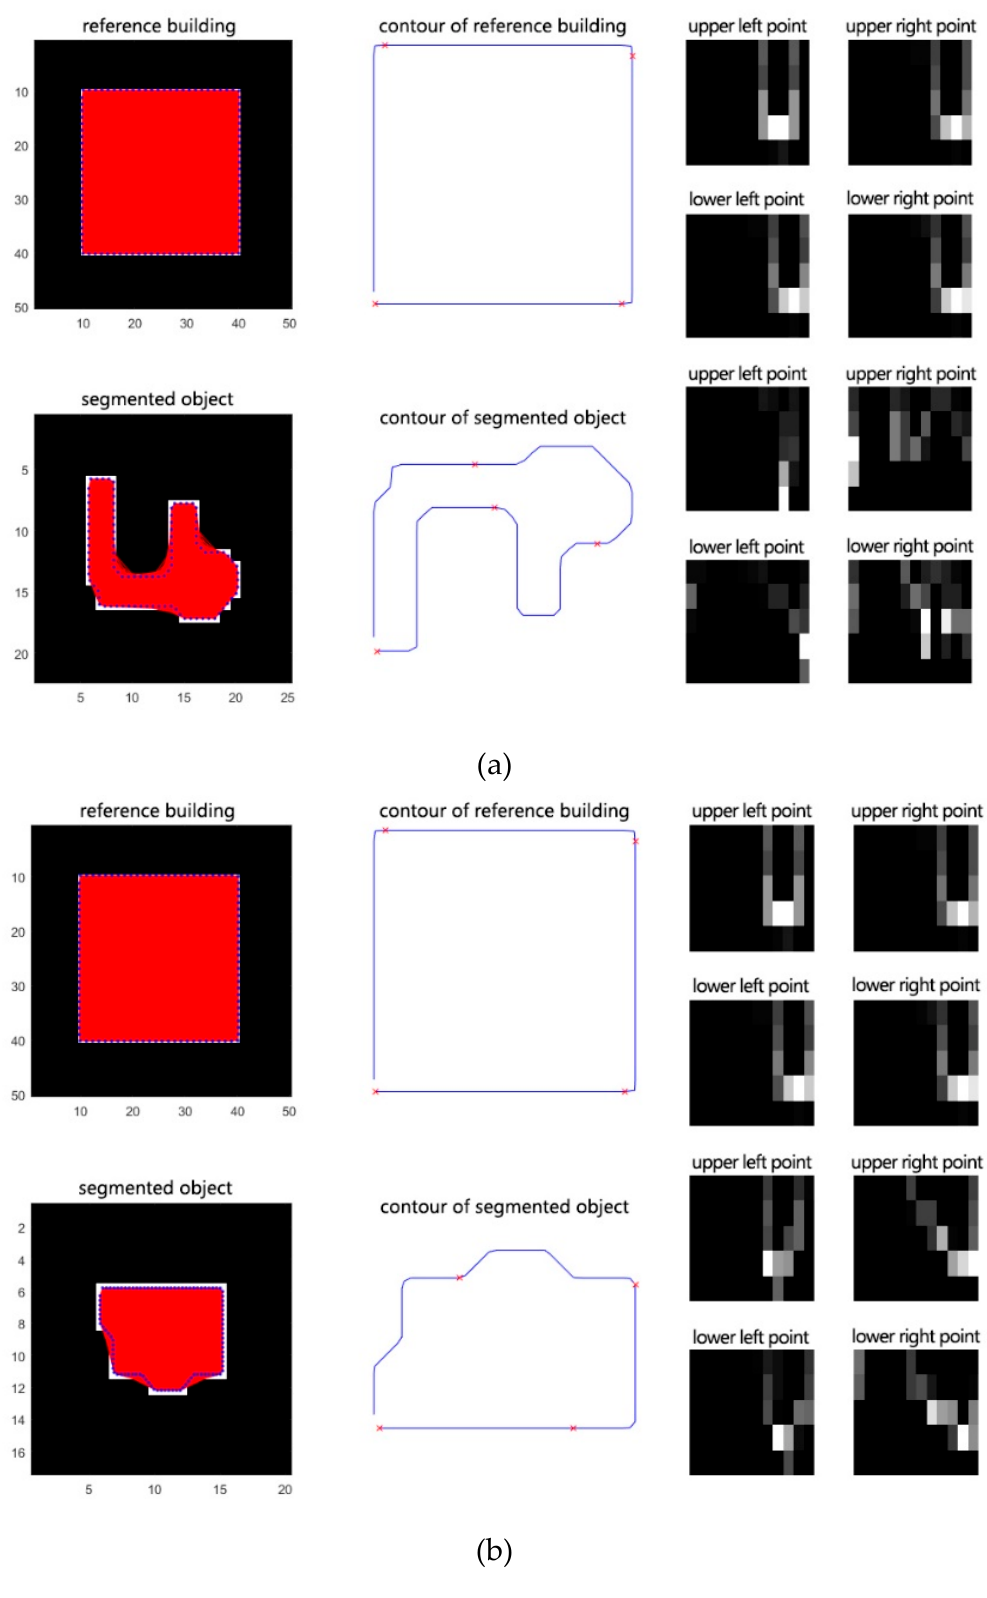
Figure 5. Shape similarity calculated using shape context: ( a ) low shape similarity with the building, and ( b ) high shape similarity with the building.